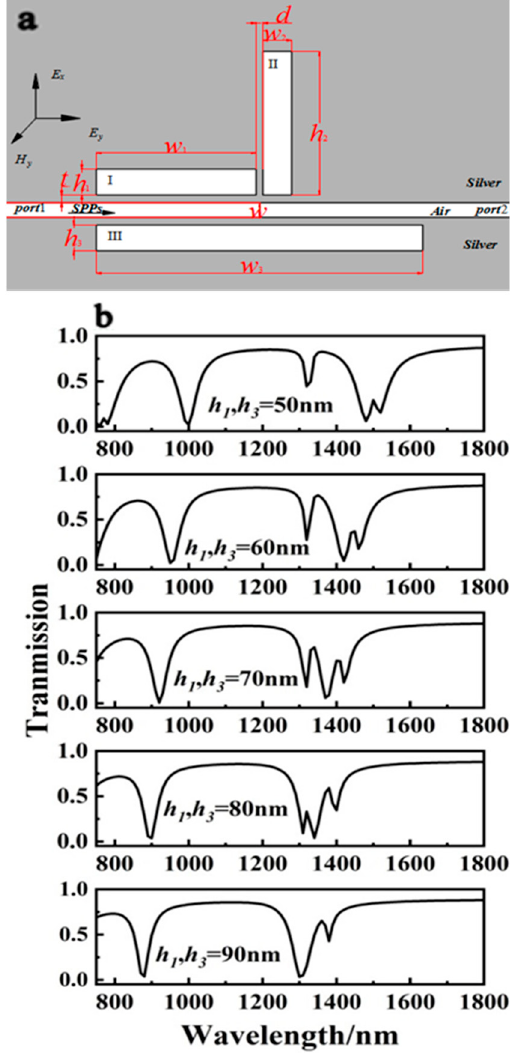
Figure 8. ( a ) Structure diagram of MIM with three rectangular resonators after adjusting cavity II. ( b ) Off-to-on transmission spectra of the four-rectangle-resonator PIT system with different h 1 and h 3 values.